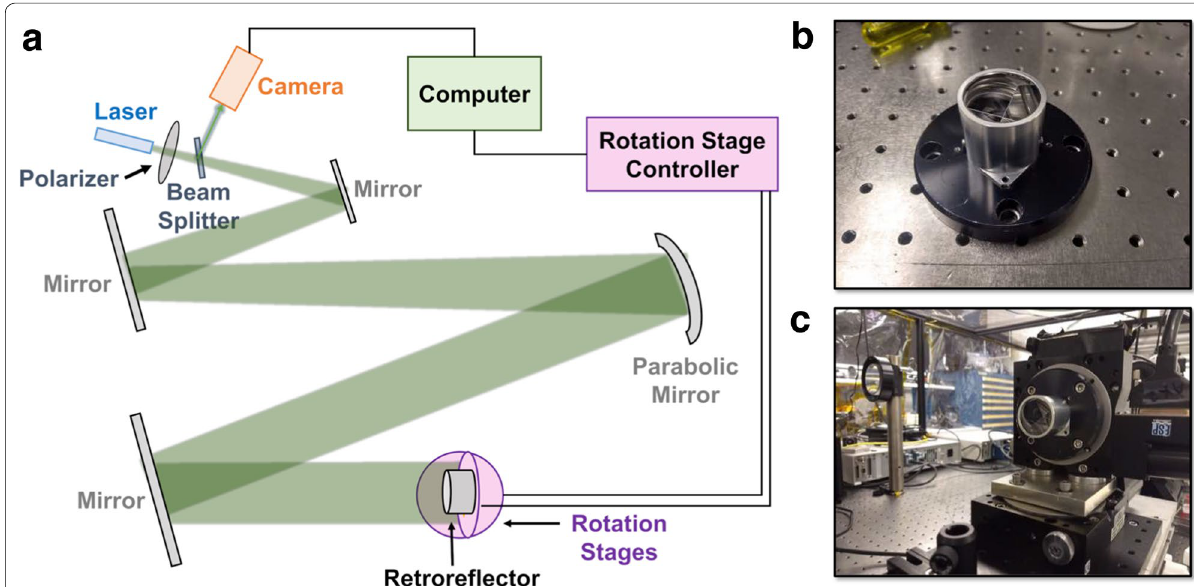
Fig. 3 Optical test setup. a Schematic representation of the LRA cross‑section measurement setup at both 532 nm and 1064 nm in 2019. b View of the LRO corner cube flight spare. c View of the RR and rotation stages on the optical test bench